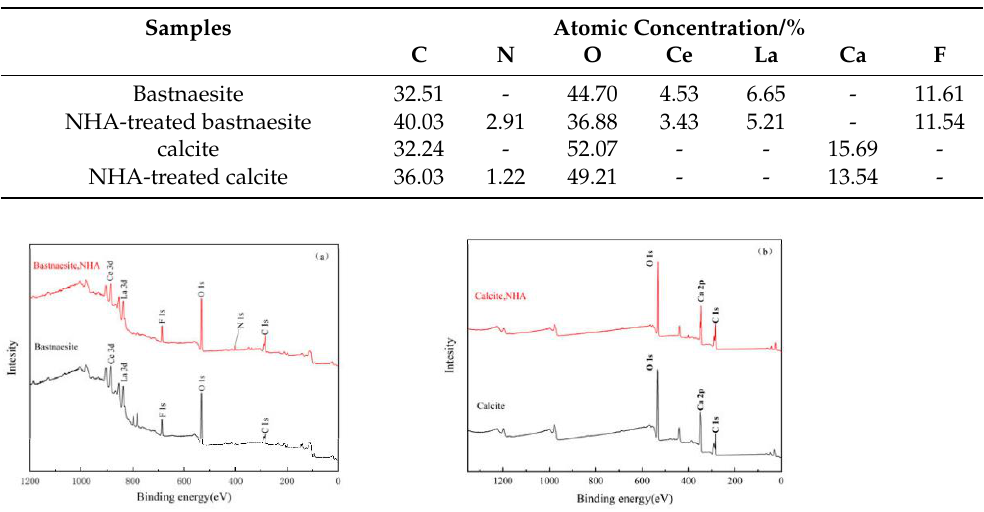
Table 6. Atomic concentrations of various elements on the surfaces of bastnaesite and calcite untreated and treated with NHA.